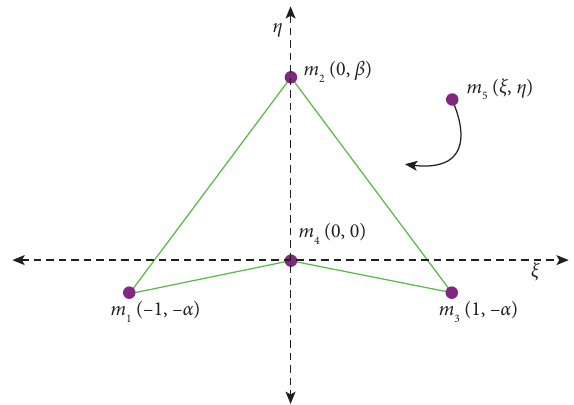
Figure 1: Te restricted concave kite fve-body